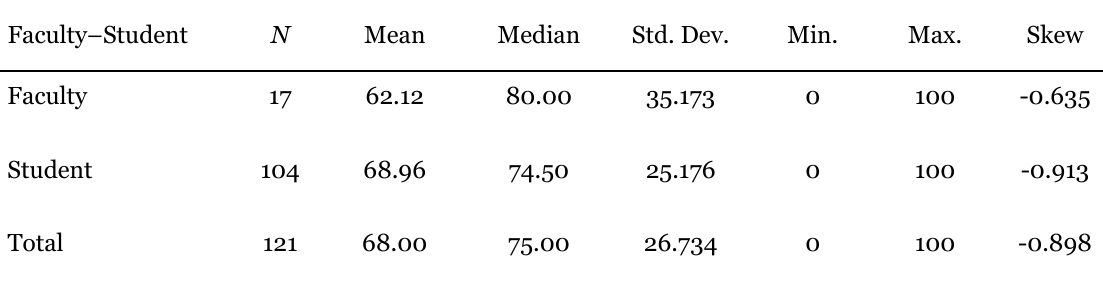
Self-Efficacy Scores: Faculty–Student Comparison